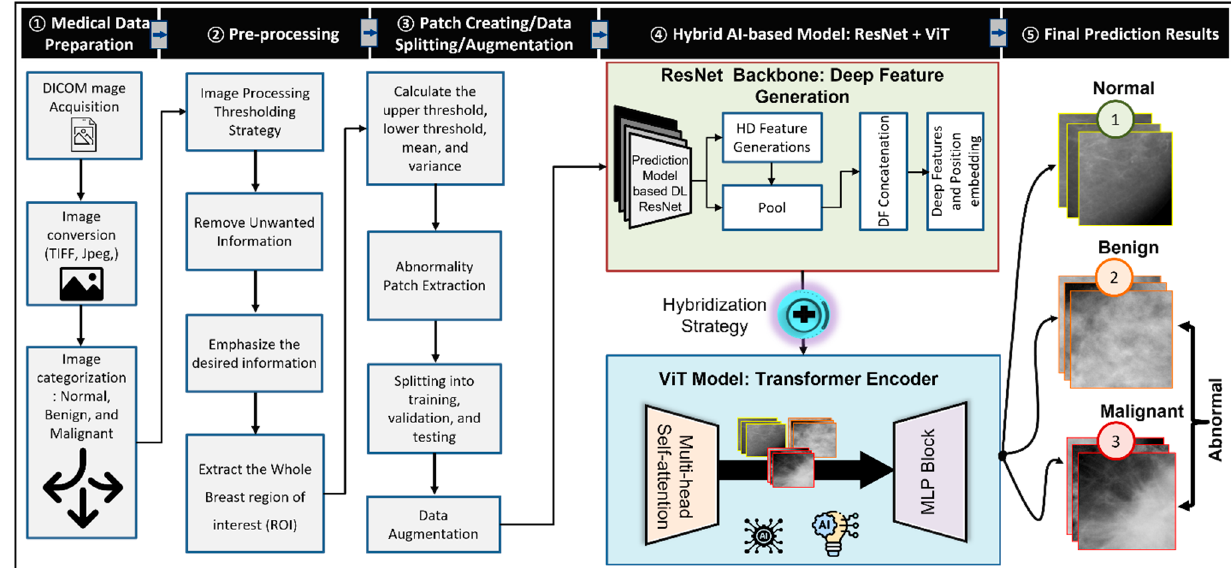
Figure 2. The proposed hybrid Computer-Aided Diagnosis (CAD) Model based on the ResNet backbone network and the Transformer Encoder (TE) with MLP.